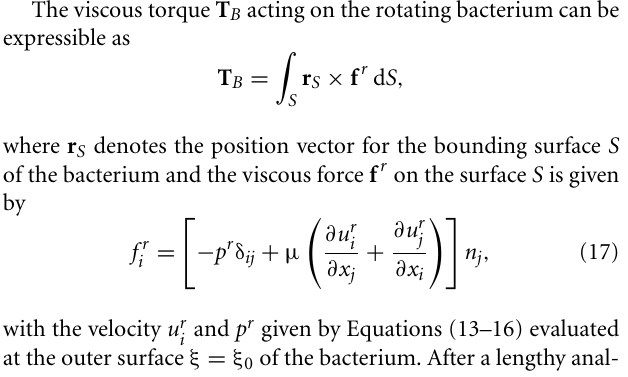
FIGURE 4 | Two cartesian coordinates, ( X, Y, Z ) and ( x, y, z ), used in our theoretical analysis, are related by the three Euler angles ( θ , ψ , φ ) and the position vector R. Cartesian coordinates ( X , Y , Z ) represent a reference of frame fixed in the laboratory while ( x , y , z ) denote a reference of frame fixed in the body of the